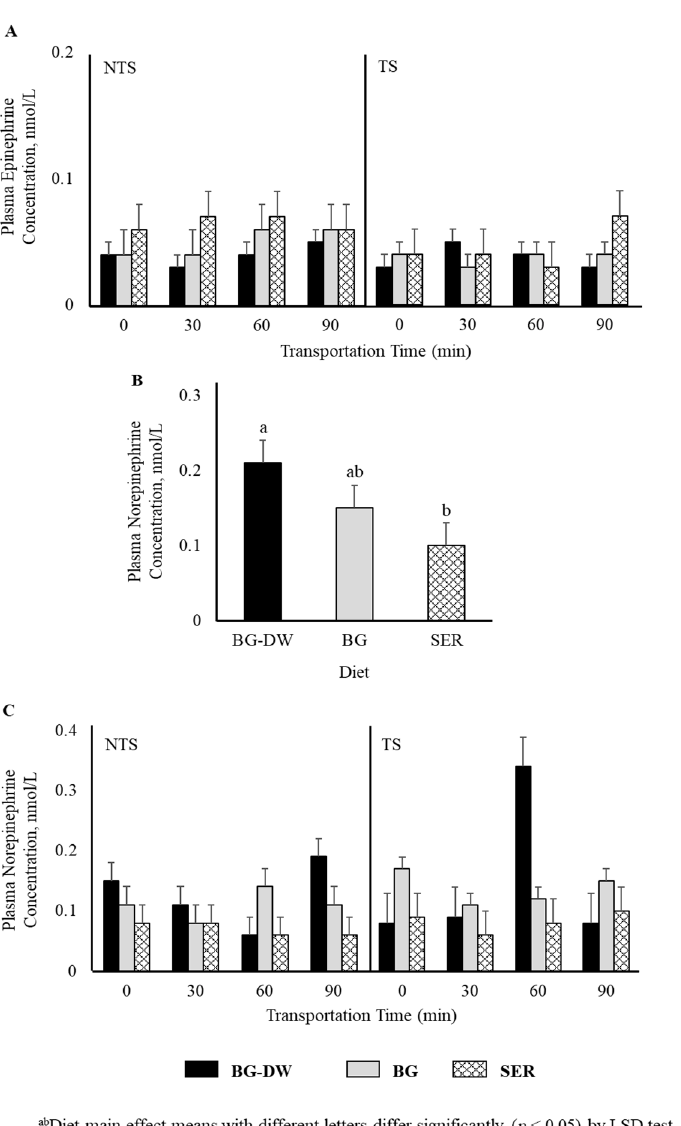
Figure 2. Effects of Diet (BG-DW: bermudagrass hay—dewormed; BG: bermudagrass hay; SER: sericea hay), Stress Treatment (ST; NTS: non-transported; TS: transported), and Time on plasma ( A ) epinephrine and ( B , C ) norepinephrine (Diet, p < 0.05; Diet × ST × Time, p < 0.01) concentrations in goats. Bars represent means with